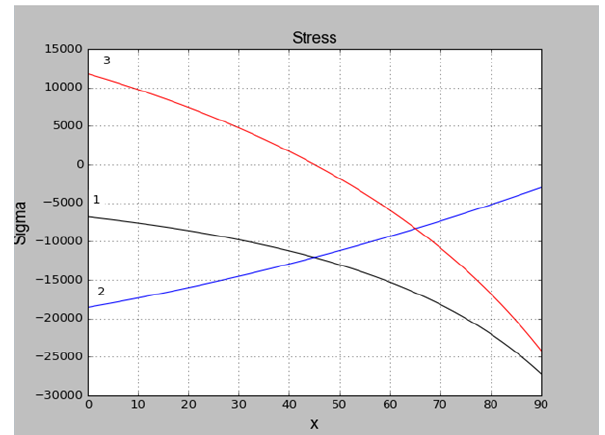
Figure 4: The laws of stress distribution: 1 - σ (x); 2 – σ T (x)u 3 – σ x (x) .